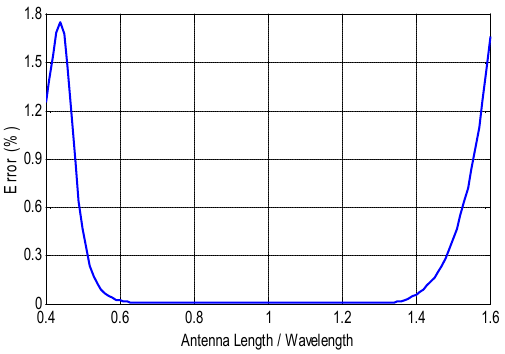
Figure 6: The normalized error for the current distributions.